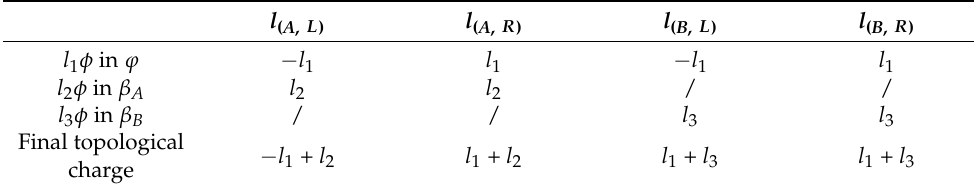
Figure 5. Rotation angles and excitation phases of sub-elements A and B for ( a ) quad CP beams without OAM and ( b , c ) quad-vortex-beam with ( b ) l (A , L) = l (B , L) = − 1, l (A , R) = l (B , R) = 1 in Case I and ( c ) l (A , L) = − 1, l (B , L) = 0, l (A , R) = 2, l (B , R) = 1. in case II ( d , e ) Simulated far-field patterns ( d ) in Case I and ( e ) in case II. Table 1. Relationship of Topological Charges of the Final Vortex Beams to Three